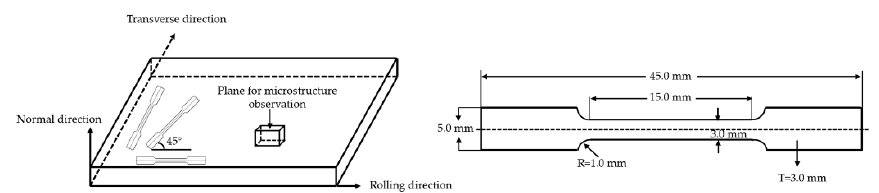
Figure 1. Schematic showing the sample extraction plan for mechanical testing and microstructure analysis ( left ), and the dimensions of the tensile testing samples ( right ).